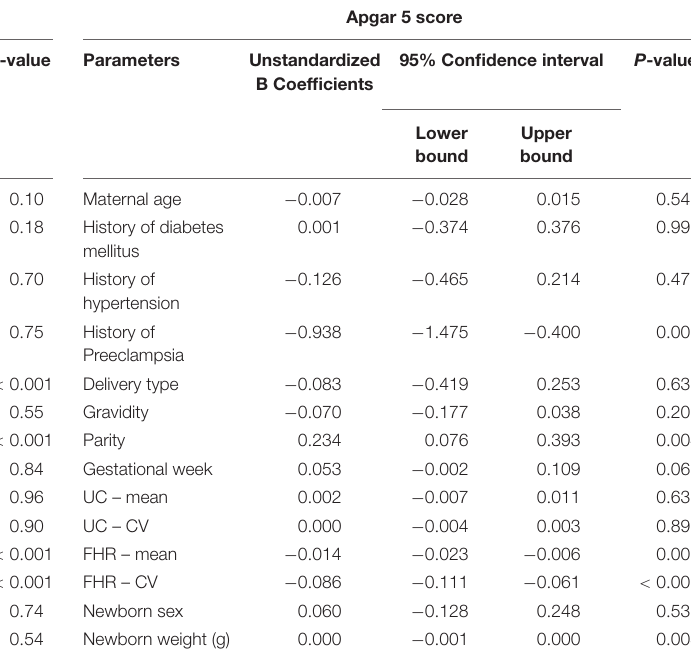
TABLE 3 | Association between maternal and newborn parameters and base deficit.